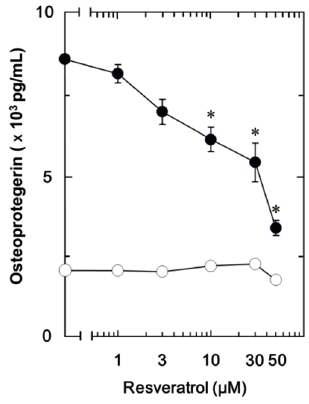
Figure 2. The dose-dependent effect of resveratrol on the FGF-2-stimulated osteoprotegerin release in MC3T3-E1 cells. The cultured cells were pretreated with various doses of resveratrol for 60 min and then stimulated by 30 ng/mL of FGF-2 ( ● ) or vehicle ( ○ ) for 48 h. Osteoprotegerin concentrations of the culture medium were determined by ELISA. Each value represents the mean ± SEM of triplicate determinations from three independent cell preparations.  p < 0.05, compared to the value of FGF-2